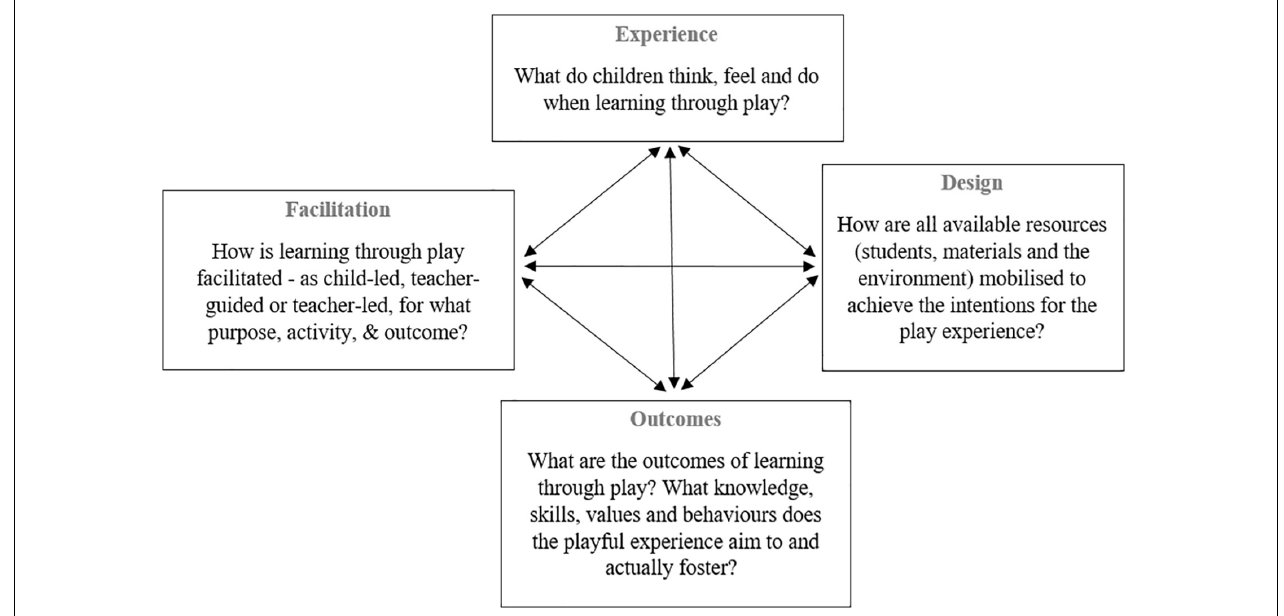
FIGURE 2 | Framework for quality learning through play at